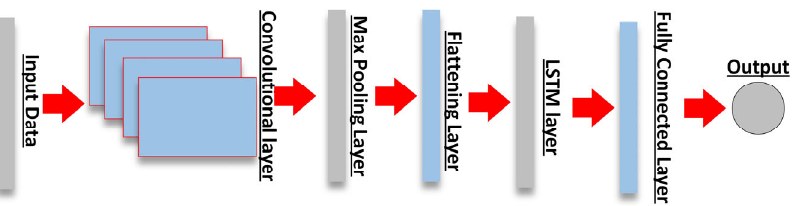
Figure 3. The structure of CNN-LSTM model.